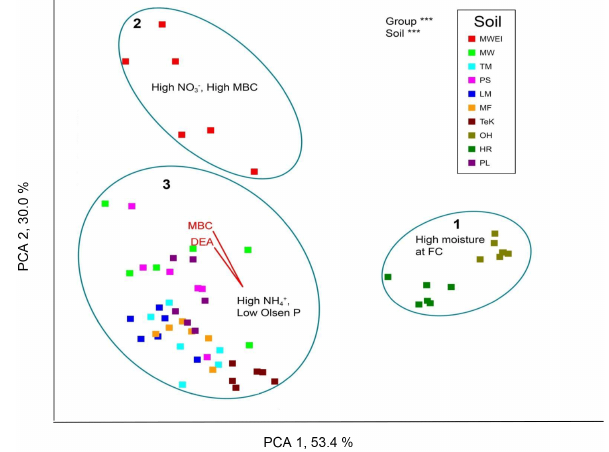
Figure 1. Principal component analysis of the physicochemical characteristics of soil samples collected at 10 dairy farms and results of a multiple response permutation procedure (MRPP) to assess the significance of soil origin and group. Vectors indicate significant correlates ( τ > 0.2) with ordination axes in the first and second PC axes.